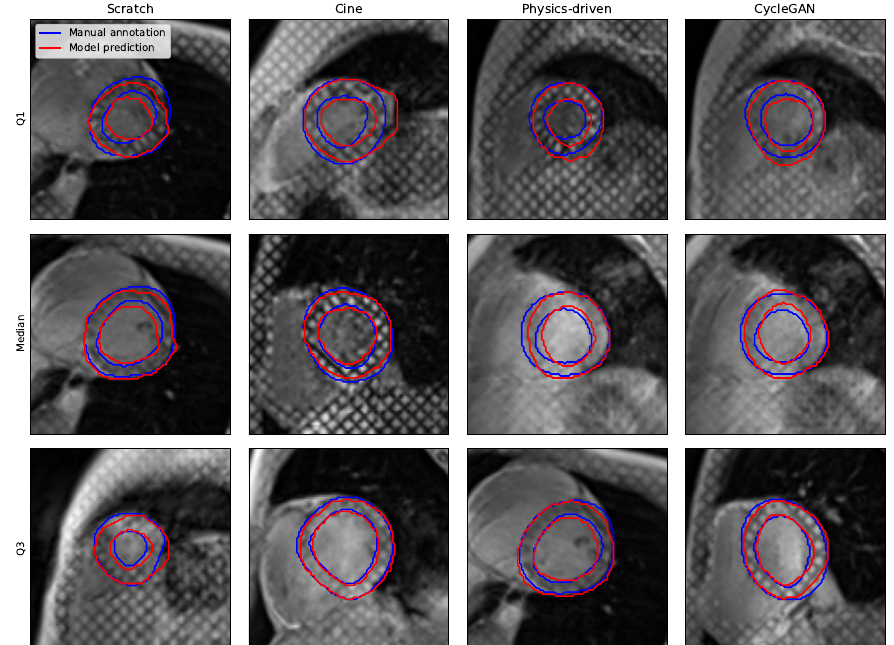
Figure 7. Qualitative segmentation results for the ResNetVAE model architecture and different pretraining strategies (with cine images, simulated tagged with physics-driven transformation, and simulated tagged with CycleGAN transformation). The Q1, median, and Q3 examples are chosen from each results distribution based on